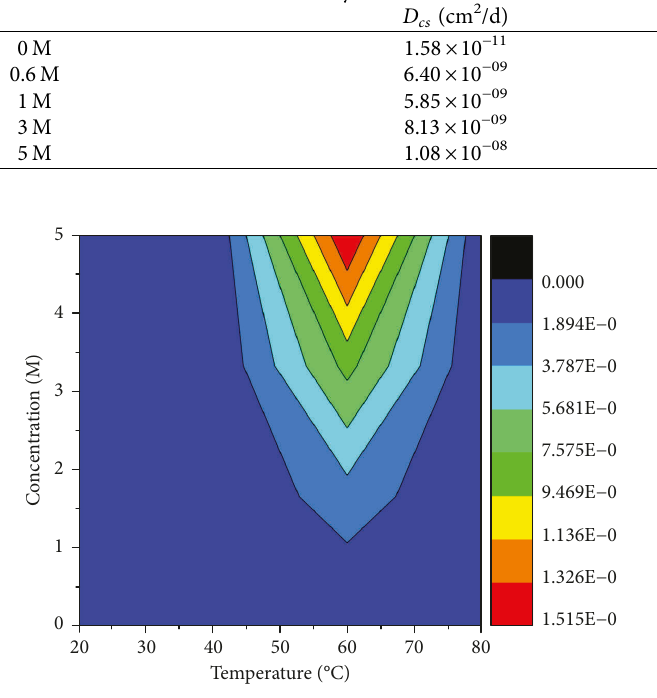
Figure 12: The distribution of ADC of Cs + in fly ash/cement waste forms at simultaneous effect.